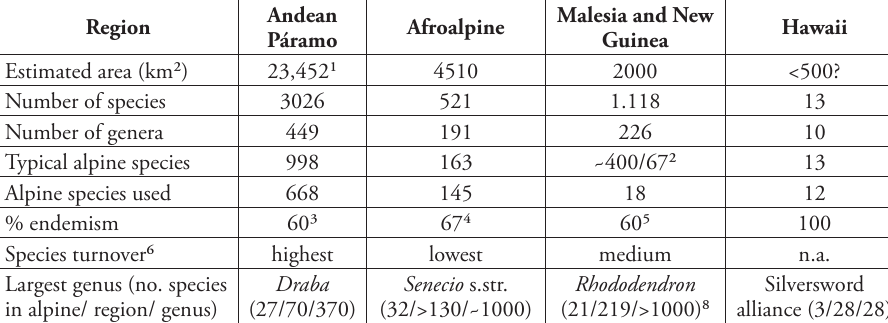
Table 1. Overview of high tropical alpine-like regions as used in this study. Andean Malesia and New Region Afroalpine Hawaii Páramo Guinea Estimated area (km²) 23,452¹ 4510 2000 <500? Number of species 3026